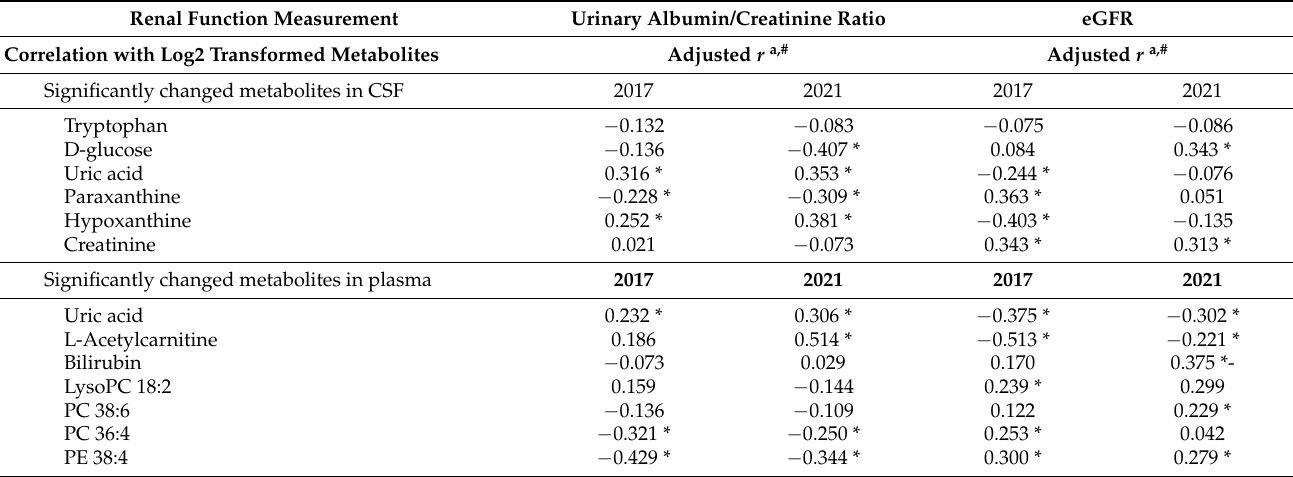
Table 6. Correlation of the log2 transformed CSF and plasma metabolites with the renal function measurements in patients with